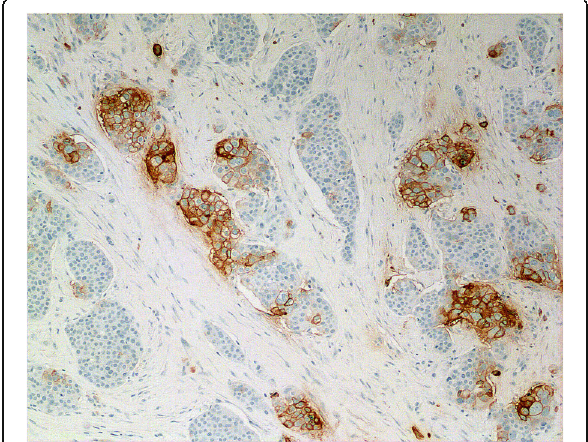
Fig. 3 Clinical image showing necrotic and fungating shoulder mass